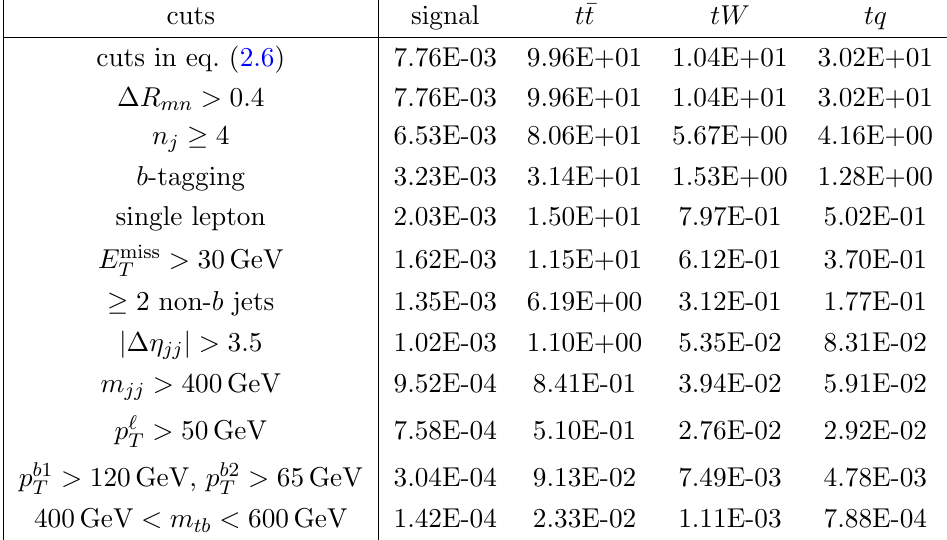
Table 2 . The cut (cid:13)ow of the signal and background cross sections (in units of pb) for m 500 GeV. The notation of \aE (cid:6) 0b" stands for a (cid:2) 10 (cid:6) b . where the quantities in the square bracket are obtained with the benchmark values F = A = 0 : 5. The signal cut e(cid:14)ciency (cid:15) t WZ A , 7 so that we are free to obtain it with the benchmark values of F t